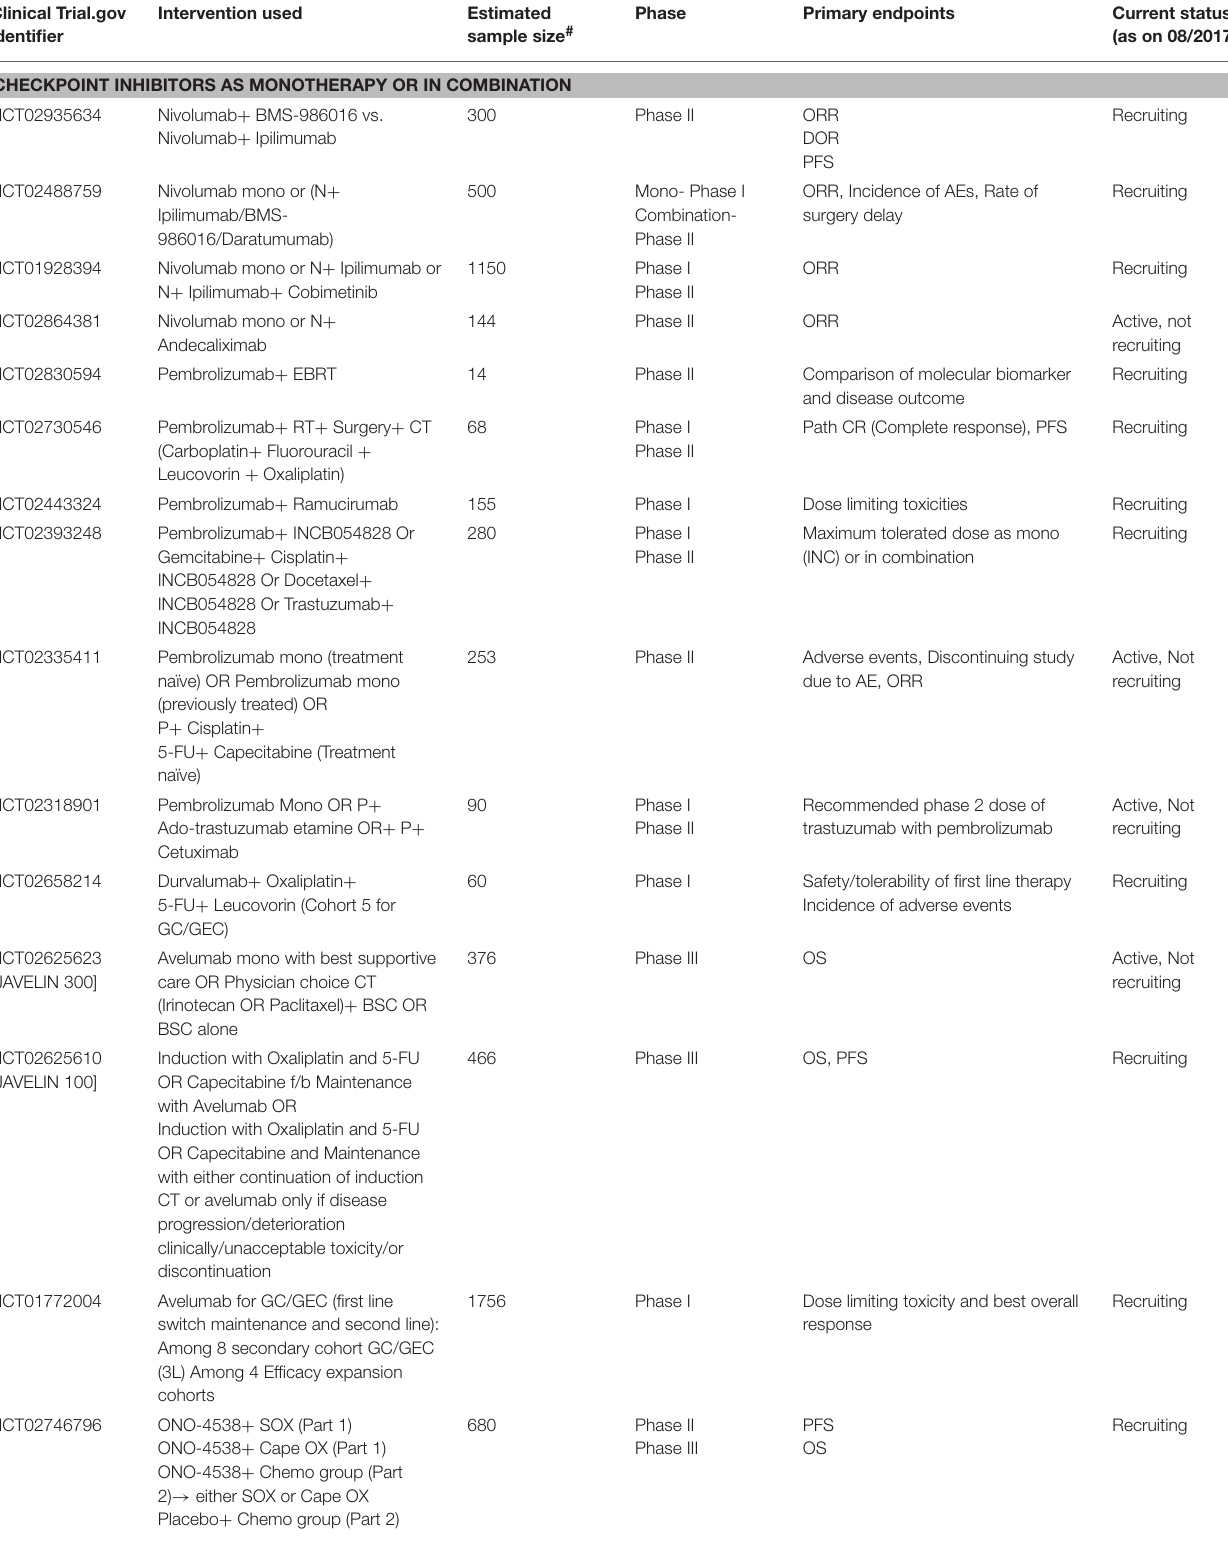
Phase Primary endpoints sample size #